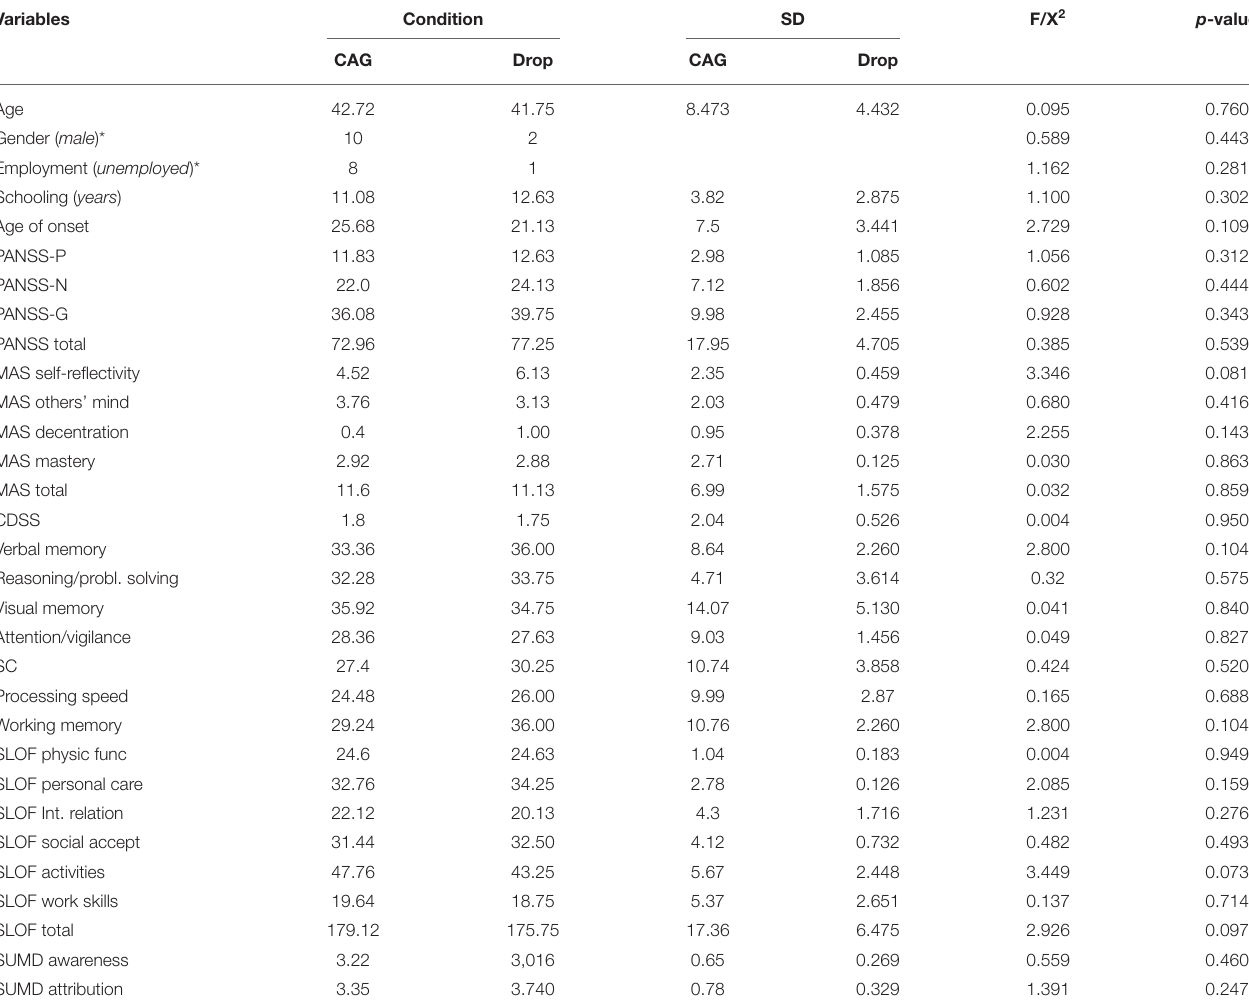
TABLE 1 | Differences between drop-outs and CAG group